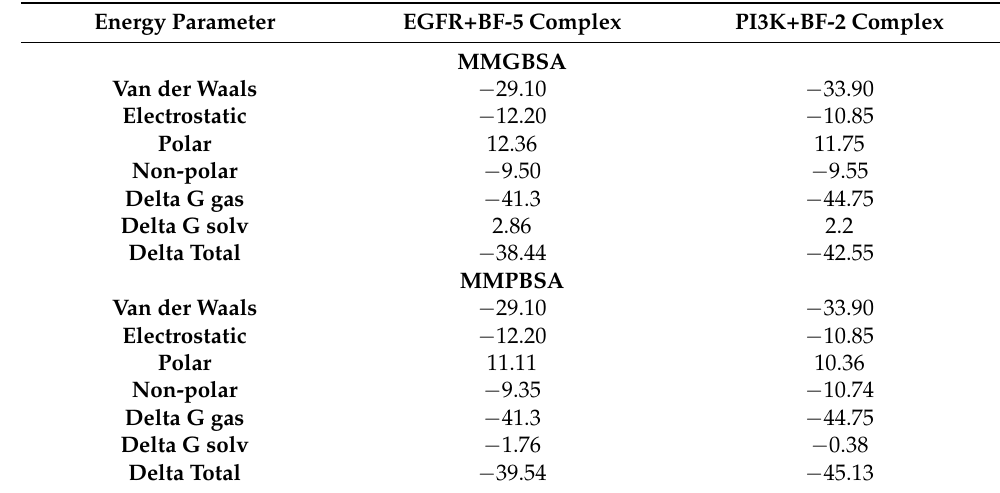
Table 8. Binding free energies of complexes in kcal/mol.